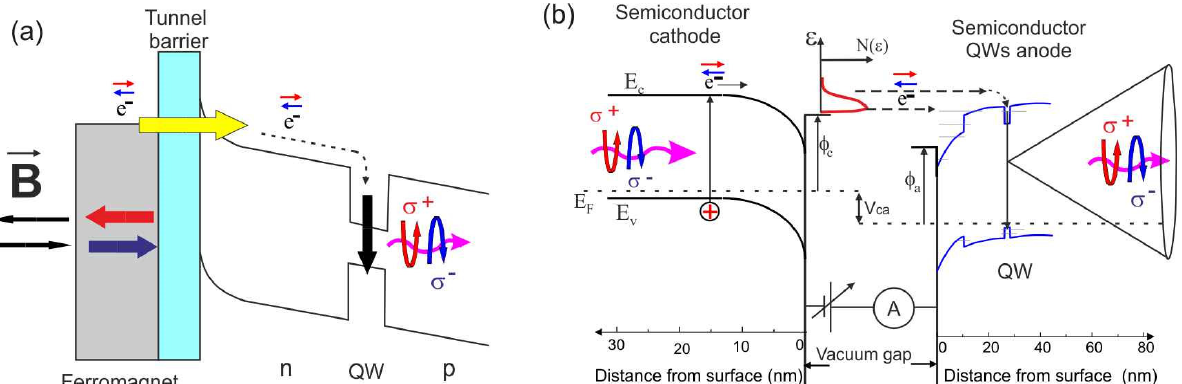
Figure 1. Transformation of monolithic spin LED ( a ) into two electrodes (anode and cathode) with the NEA states separated by the vacuum gap ( b ). Spin-polarized electrons emitted from the cathode and injected to the anode through the vacuum gap. In the case of a monolithic spin LED, an FM contact (or/and a magnetic semiconductor) and an external magnetic field are required to switch between polarizations, whereas a vacuum spin LED uses only the optical pumping effect to create, inject, and detect the spin polarization.